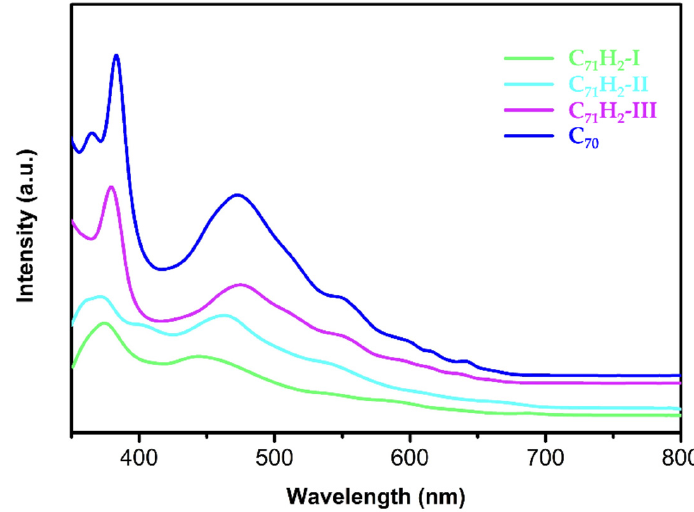
Figure 3. UV-Vis spectra of C 71 H 2 -I ( c–c ), C 71 H 2 -II ( a–b ), C 71 H 2 -III ( e–e ), and D 5h -C 70 in toluene.